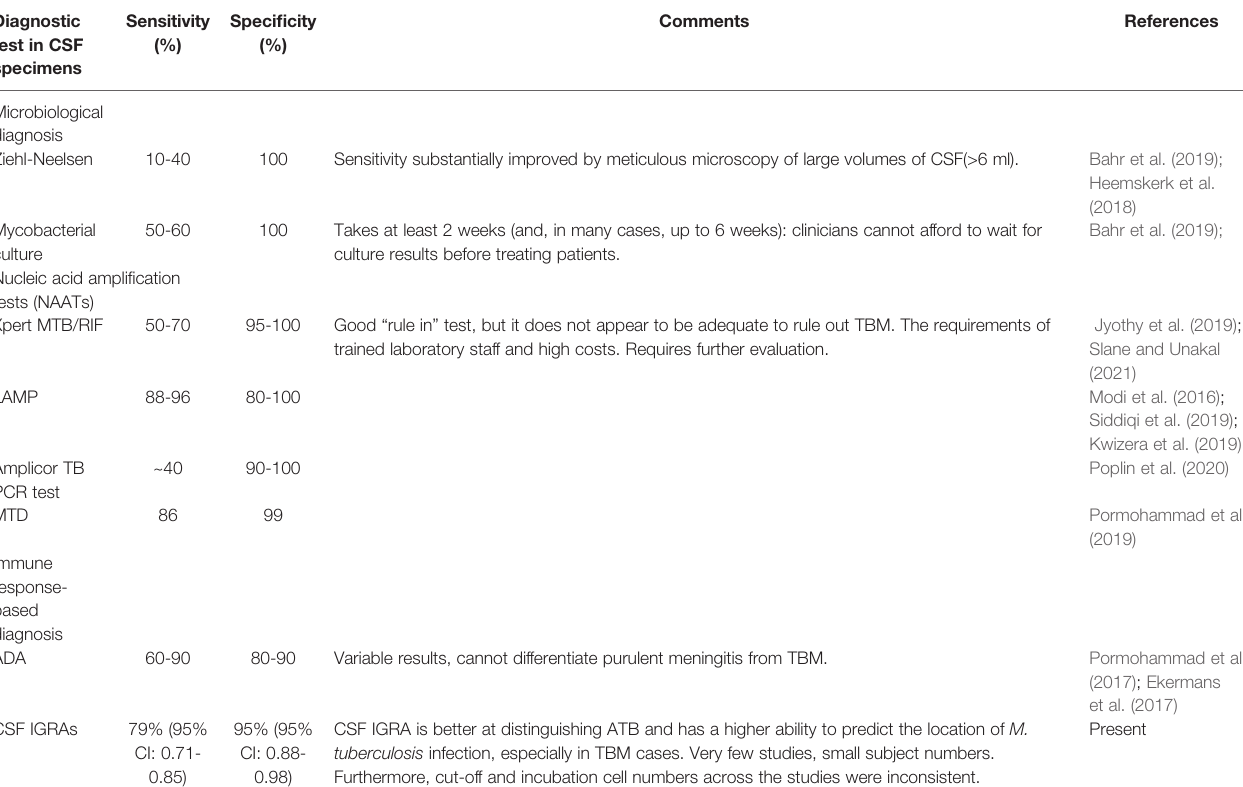
TABLE 3 | Comparison of conventional and novel diagnostic tests for tuberculous meningitis performed on CSF specimens. Diagnostic test in